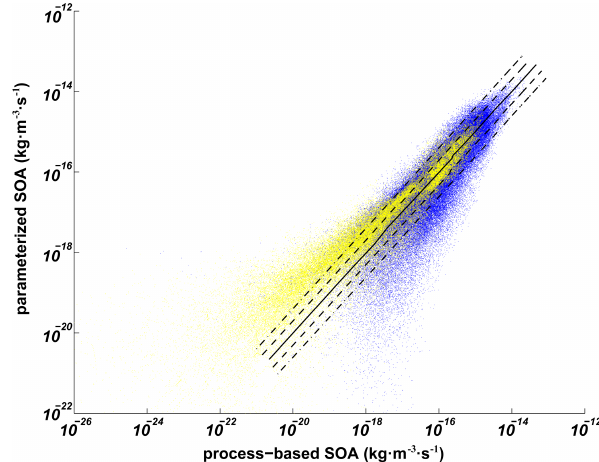
Fig. 3. Comparison between the parameterized and process-based annual mean P SOAcld for every grid box below 200hPa. Yellow dots indicate two polar regions as well as altitudes above 400hPa. The solid line indicates the 1:1 line; the dashed lines indicate the 1:2 (or 2:1) lines; the dash-dot lines indicate the 1:4 (or 4:1) lines.